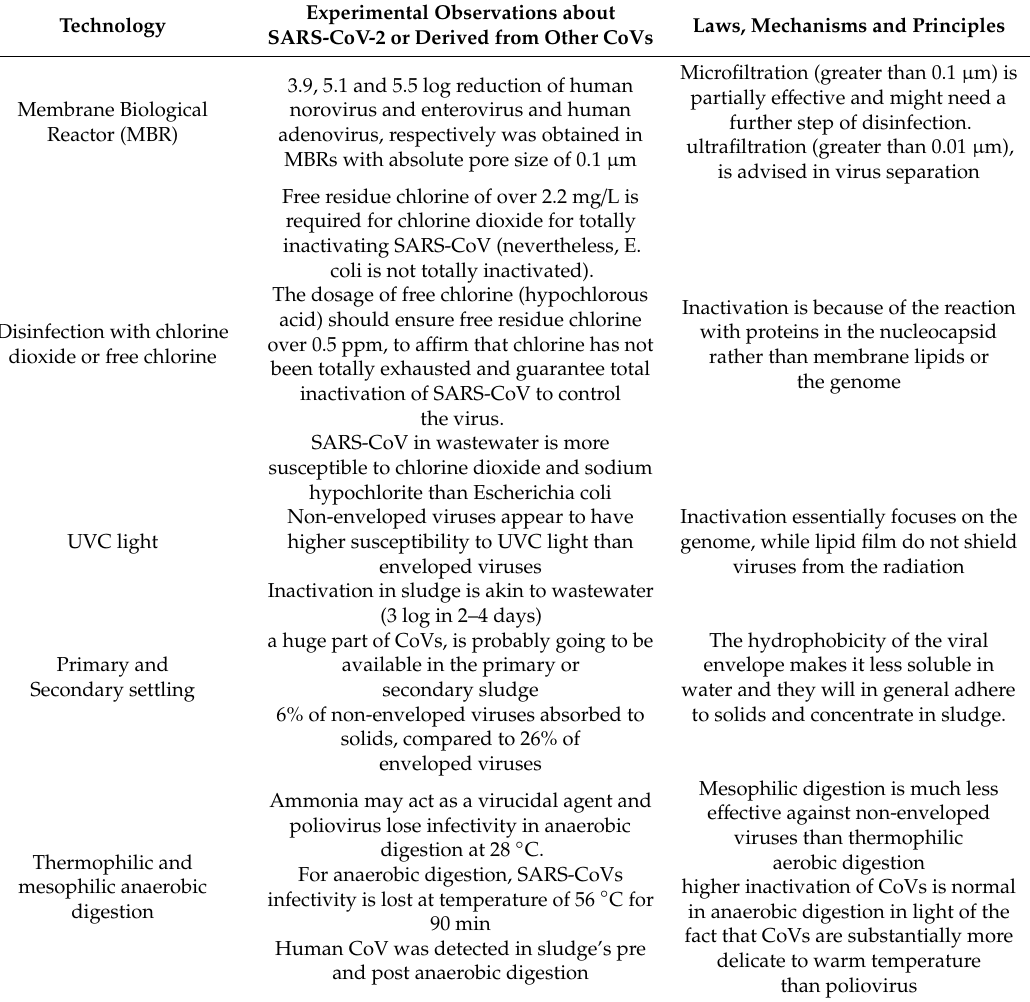
Table 5. Experimental observations about SARS-COV-2 or derived from other CoVs in WWTPs; Adapted from